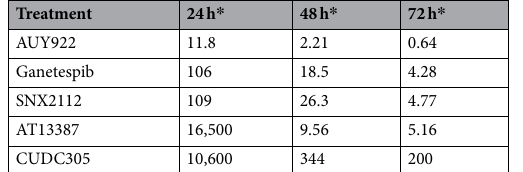
Table 1. The half-maximal inhibitory concentration value (IC 50 ) of 5 heat shock protein 90 inhibitors at different time points in bladder carcinoma 5637 cells. * 24-h IC 50 , 48-h IC 50 , or 72-h IC 50 ; Unit: